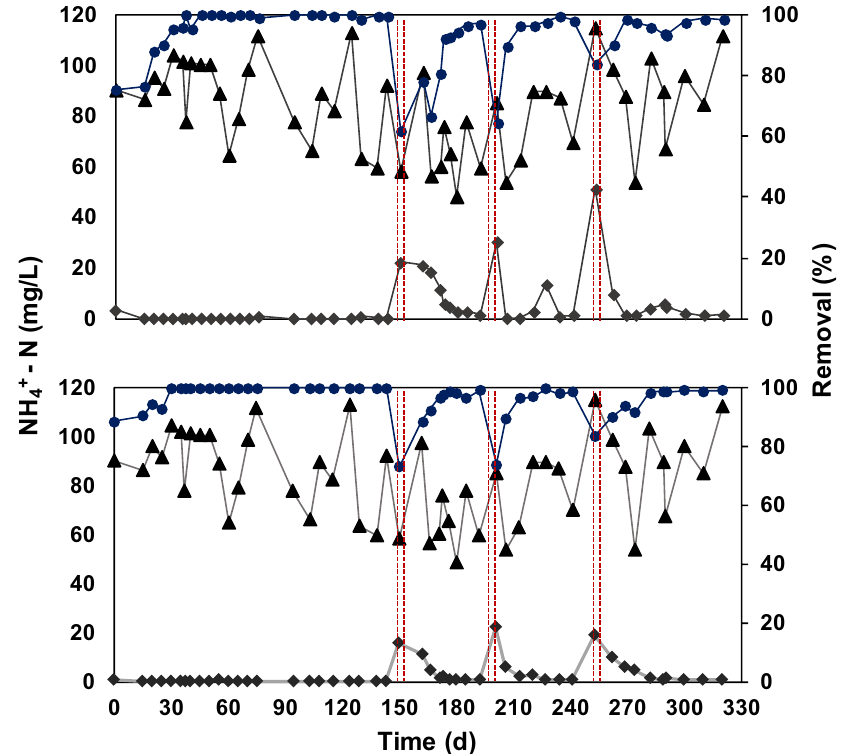
Figure 3. Removal efficiency of NH 4 + -N with UASB effluent. Where ( a ) is R1 polyurethane foam and ( b ) is R2 polyethylene rings. (filled circle) Chemical Oxygen Demand (COD) removal percentage; (filled triangle) influent and (fille diaamond) effluent. Lines show days in which the nitrifying and denitrifying activities were performed discontinuously in both